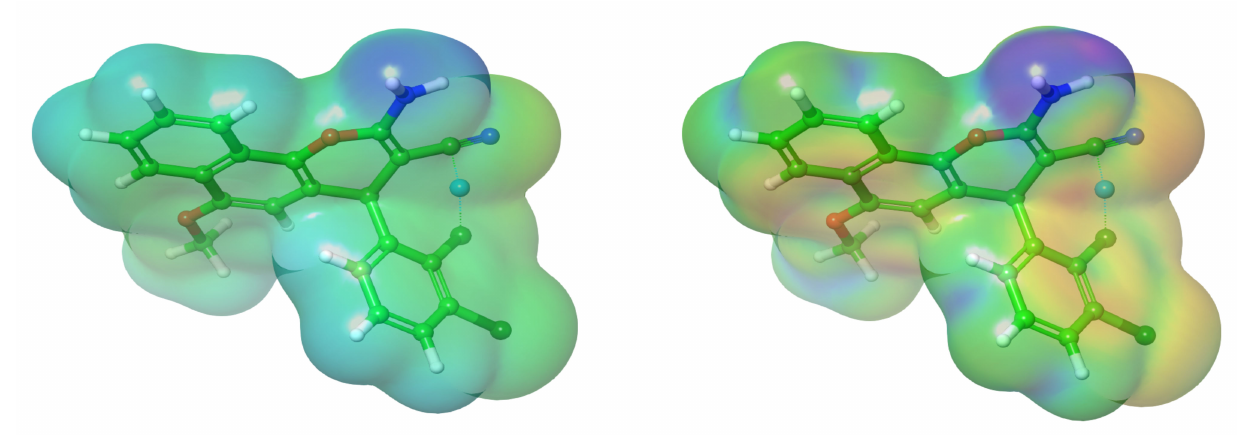
Figure 5. FMO included HOMO and LUMO, AEPM and ALIE for molecule 4 .